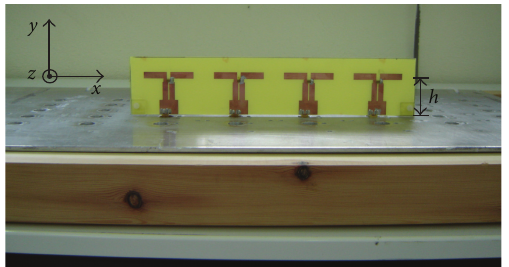
Figure 6: Uniform Linear antenna array on reflector plate.